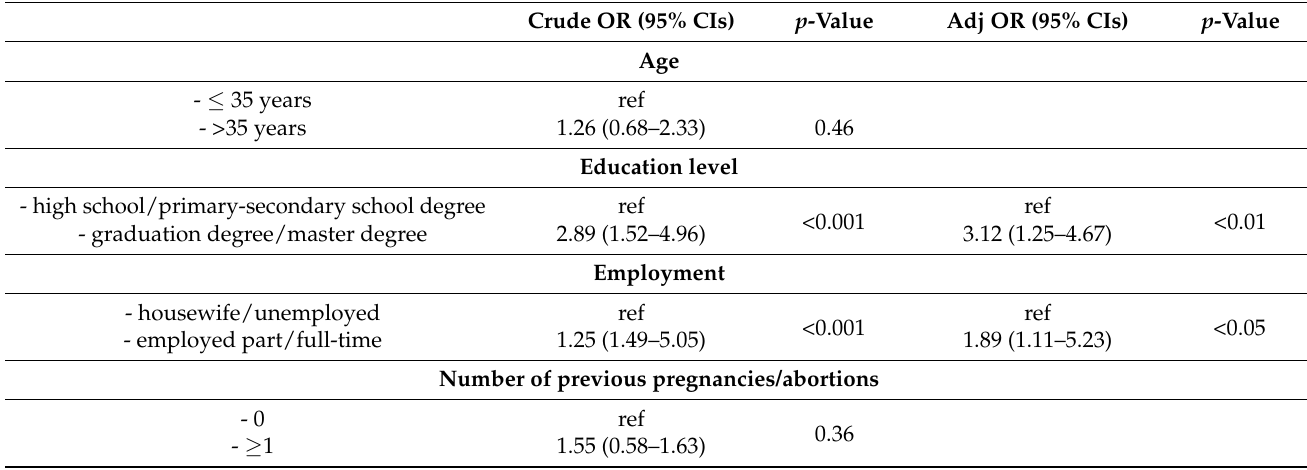
Table 4. Factors associated with influenza and DTPa vaccination adherence (receiving at least one of the recommended vaccination during pregnancy in the month following the educational interventions) among pregnant women responding to the follow-up survey (129 women vaccinated with at least one vaccine on 201 that responded). Vaccination Adherence (Receiving at Least One of the Recommended Vaccination) after Educational Interventions Crude OR (95% CIs) p -Value Adj OR (95%